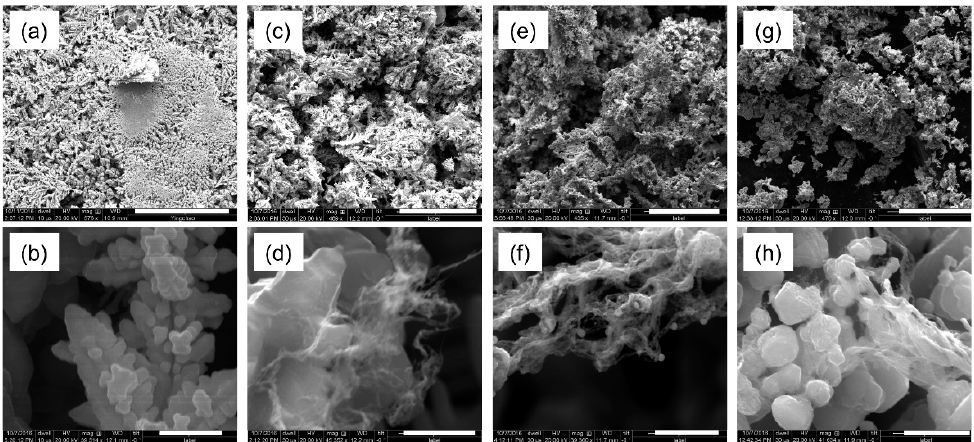
Figure 1. Representative SEM images of electroplated copper single walled carbon nanotube (Cu–SWCNT) composites electrodeposited (at a bath temperature of 60 °C) using 0 wt% SWCNT ( a , b ), 2.3 wt% SWCNT ( c , d ), 3.8 wt% SWCNT ( e , f ), and 6.2 wt% SWCNT ( g , h ). Scale bar = 100 µ m ( a , c , e , g ) and 1 µ m ( b , d , f , h ).